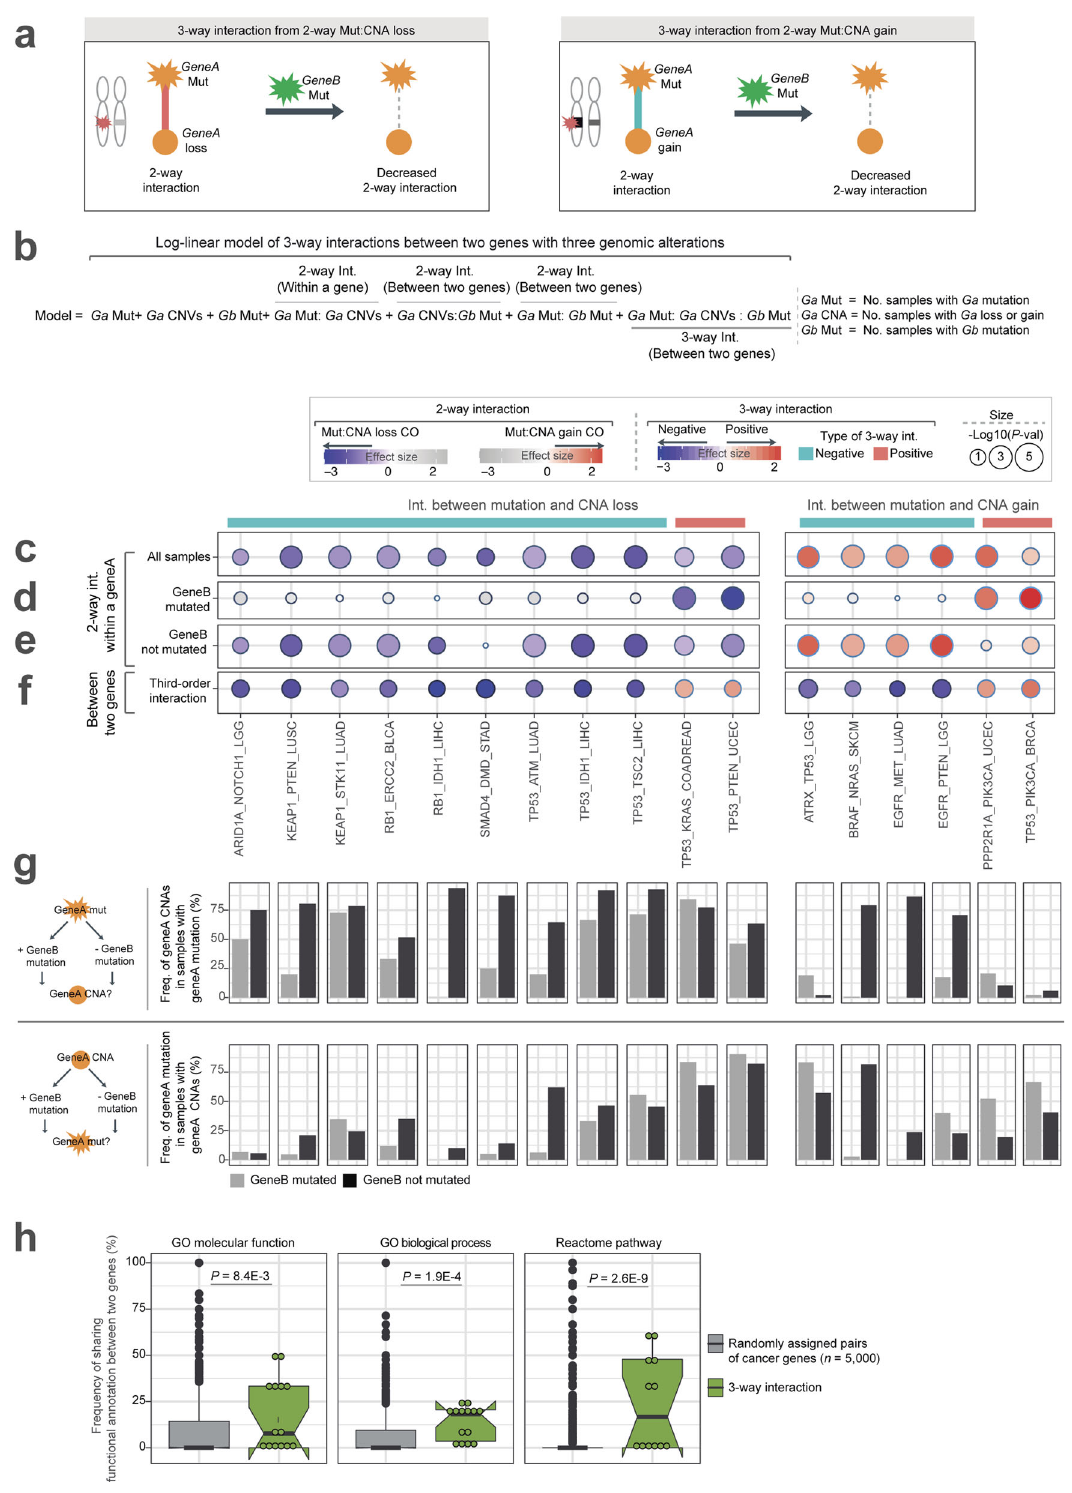
Somatic genomic alteration . Genomic data from TCGA Data were obtained from TCGA data Portal (Pan-Can Atlas). We downloaded version 2.8 of the mutation annotation format (MAF) fi le provided by the ‘ Multi-Center Mutation Calling in Multiple Cancers ’ (MC3) project, as a part of the TCGA Pan-Cancer Atlas effort 22 . These uni fi ed MC3 somatic mutations were called from seven software packages using a single-standardized protocol across many different individual studies (mc3.v0.2.8.PUBLIC.maf.gz). It provides high-quality variant calls after applying rigorous fi ltering steps to discard low-quality variants and remove possible sequencing artifacts. Somatic mutation calls were assigned to all premature